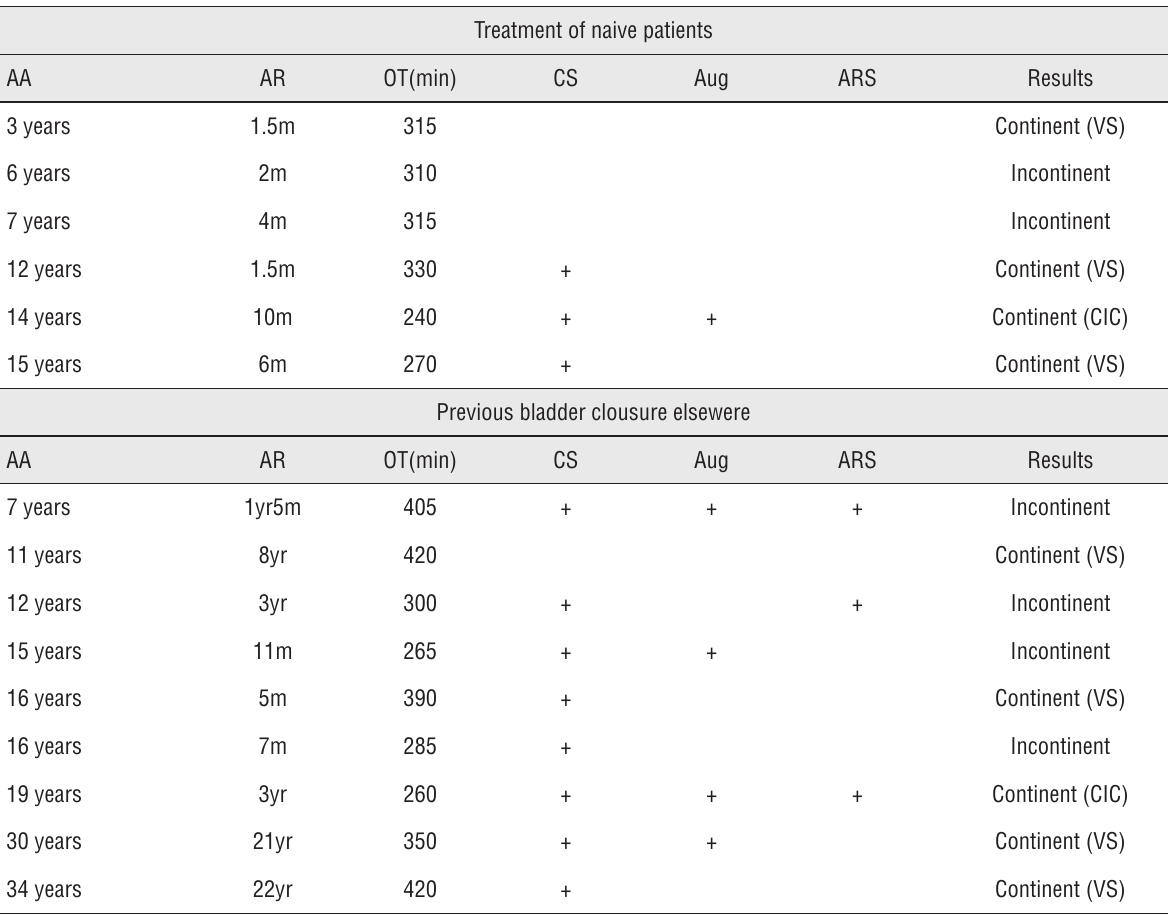
Table 2 - Patient characteristics and results of operation with one-stage